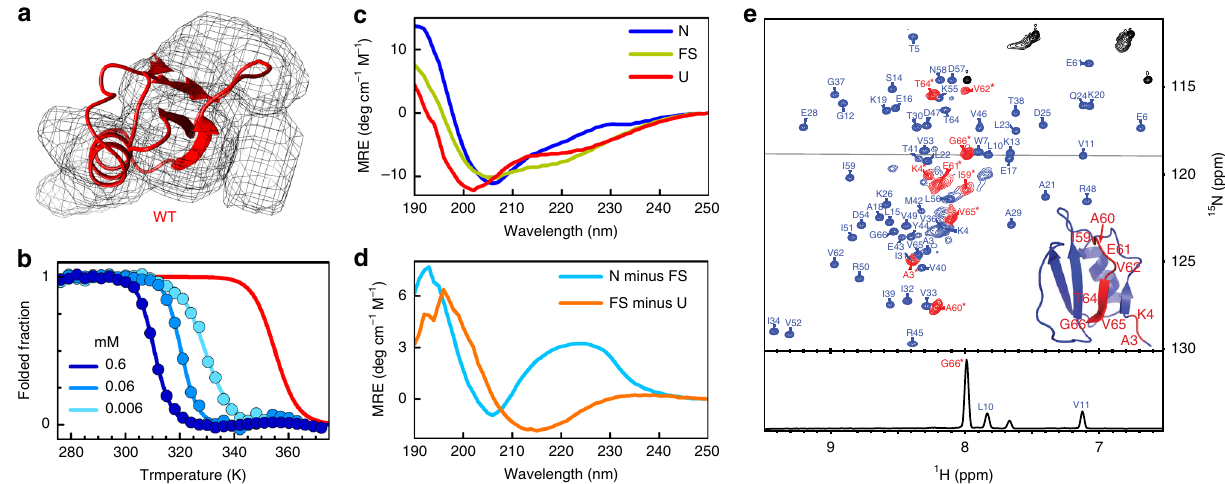
Fig. 4 The concentration-dependent fold-switch transition of CI2 eng . a CI2 native structure superimposed onto the electron density of one monomer in the cryo-EM 3D model. b Equilibrium thermal unfolding of CI2 eng at various protein concentrations (shades of blue) monitored by tryptophan fl uorescence. Unfolding of wild-type CI2 is shown in red for comparison. c Far-UV CD spectra corresponding to the three species detected during thermal denaturation (see Fig. s10). (Blue) spectrum of the CI2 eng native structure as measured at 314 K. (Light green) spectrum of the alternate conformation (FS), measured at a temperature within the second plateau of the unfolding transition (346 K). (Red) spectrum of the thermally unfolded protein measured at 376 K. d Difference between the CD spectra of the native and alternate conformation (light blue) and between the alternate conformation and the unfolded state (orange). e [ 1 H- 15 N]HSQC spectrum of CI2 eng at 1 mM and 308 K. All backbone amide cross-peaks and assignments in the spectrum correspond to signals from one sample, but they are shown in different color for the monomeric species (blue) and for the assembly (red) to facilitate their distinction. The inset highlights CI2 eng residues with cross-peaks that are visible in the assembly. (Bottom) 1D 1 H slice illustrating the different intensity of monomer (L10, V11, and K13) and assembly (G66*) cross-peaks, representing their equilibrium